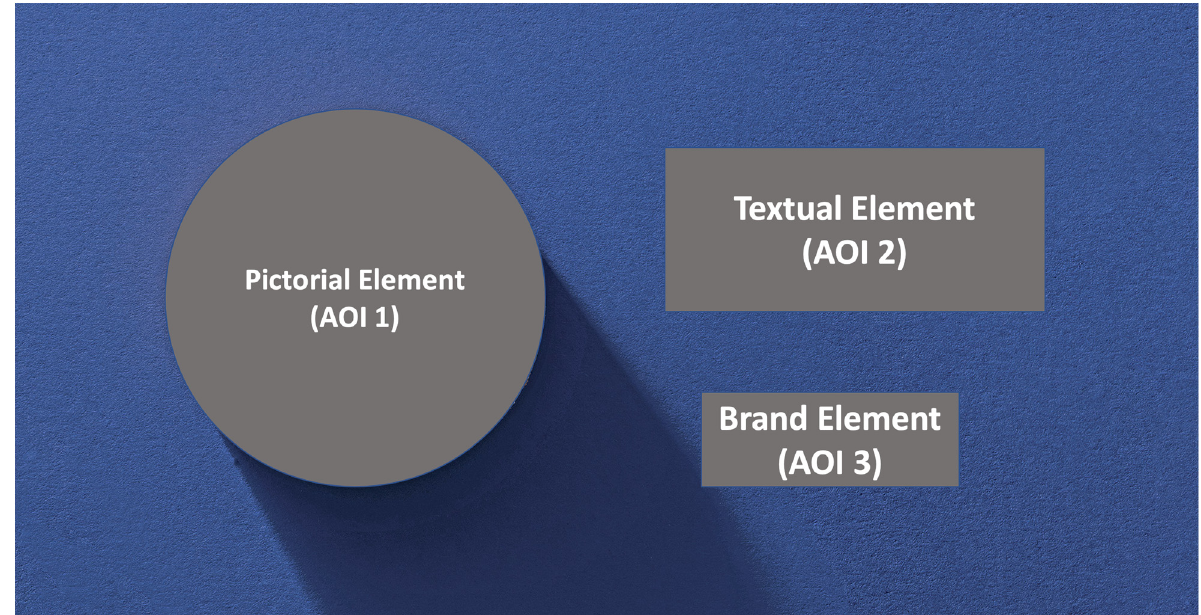
Figure 3. Each banner ad consisted of three key elements: pictorial, textual, and brand elements. Three areas of interest (AOI) were selected for eye-tracking analysis: pictorial element (AOI-1) consisting of the picture of the product, textual element (AOI-2) consisting of the endorsing text, and brand element (AOI-3) containing the logo of the brand. The size AOI-3 was exactly the same across all banners, whereas the sizes of AOI ‐ 1 and AOI ‐ 2 differed across banners by less than 5%.